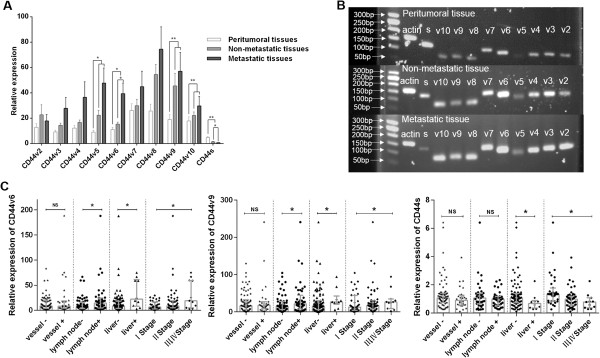
Expression levels of CD44v and CD44s in clinical pancreatic carcinoma tissues. A The expression levels of CD44v and CD44s were tested in metastatic tissues (n = 5), non-metastatic tissues (n = 5) and their corresponding peritumoral tissues (n = 10). B The PCR products of tissues were confirmed by agarose gel electrophoresis. C The expression levels of CD44v6, CD44v9 and CD44s measured by real-time PCR were associated with the clinical characteristics of pancreatic carcinoma (n = 101).